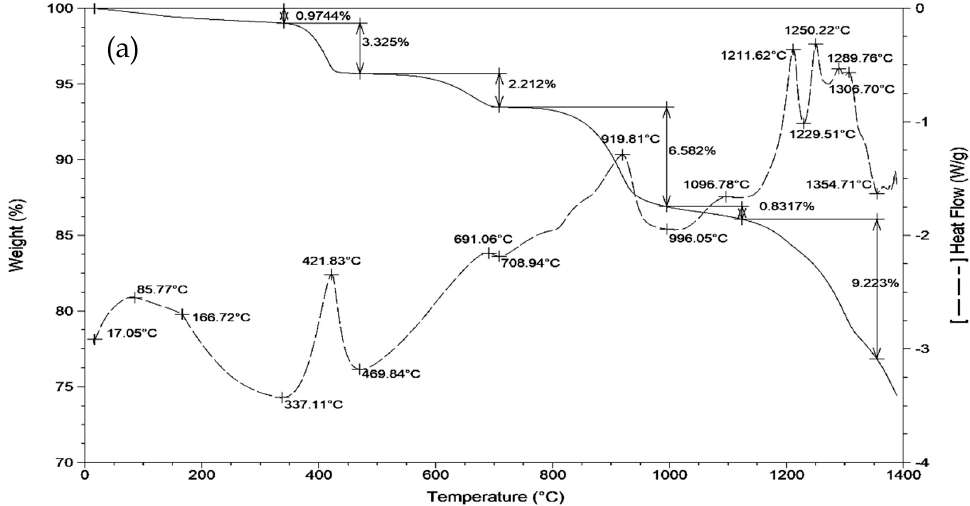
Figure 2. Comprehensive thermal analysis (DSC-TG) curves of the mixtures: ( a ) I-1; ( b ) II-1; ( c ) III-1.